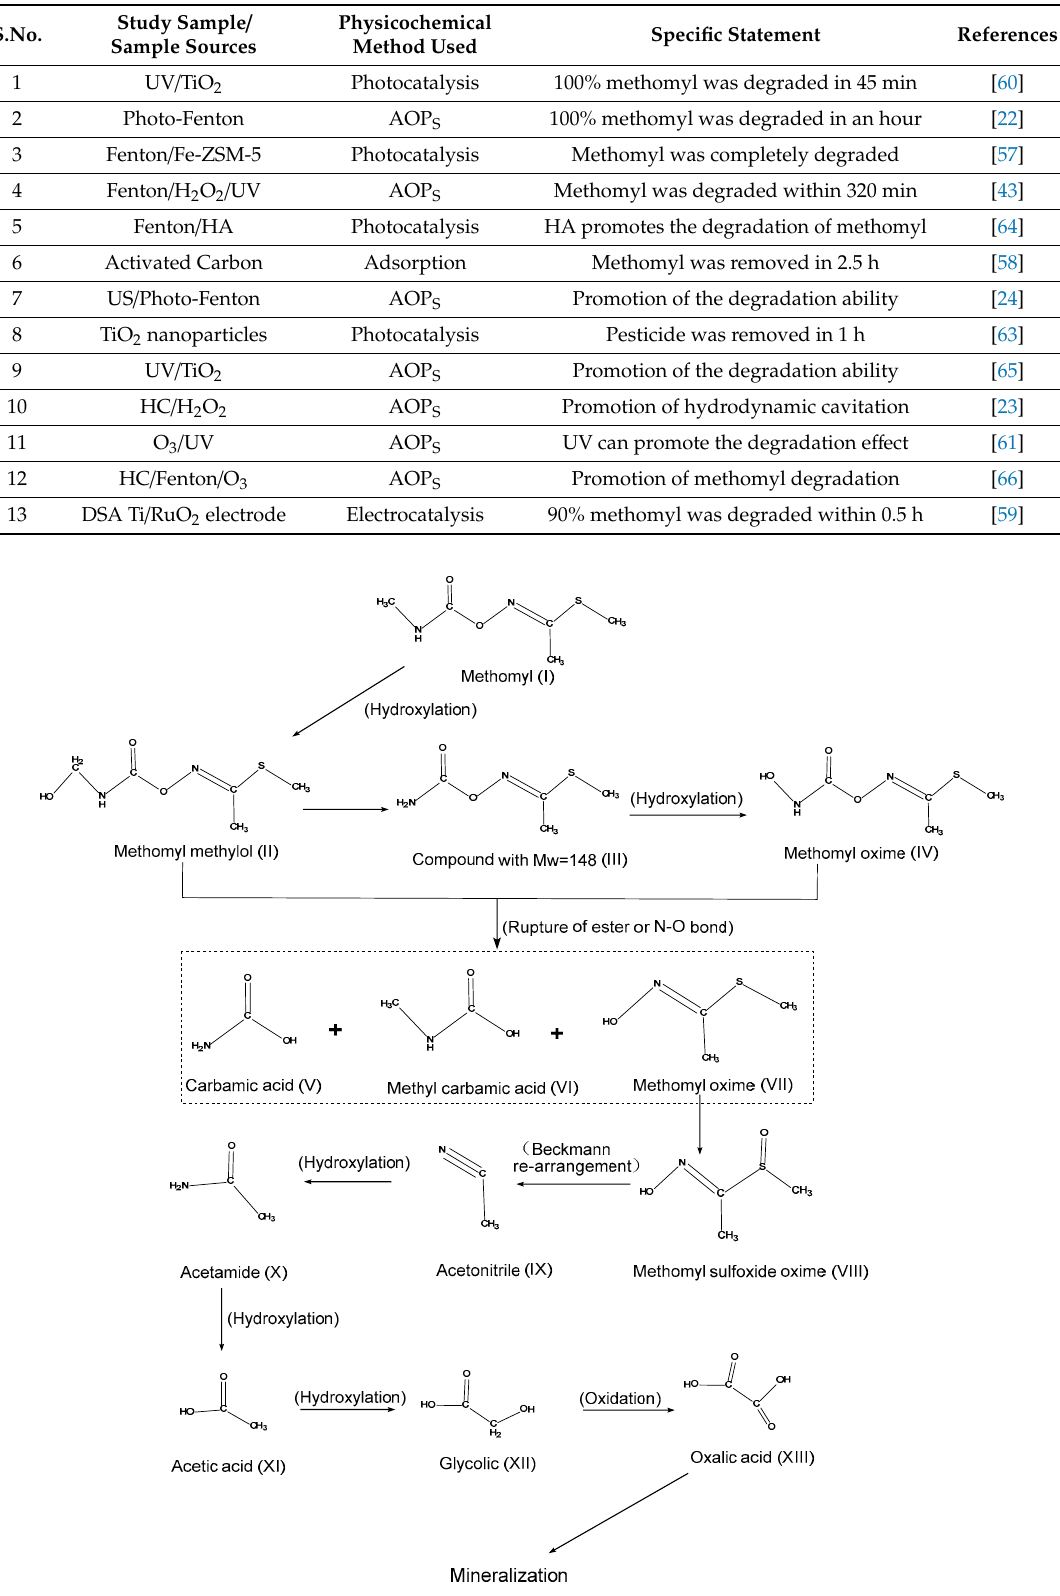
Figure 3. Methomyl degradation pathways by physicochemical methods, adapted from [24,65]. Hydroxyl radicals can effectively degrade methomyl, which is unstable and highly reactive [52]. In the Fenton/H 2 O 2 system, both Fe(OH) 2+ and H 2 O 2 can produce a large number of hydroxyl radicals